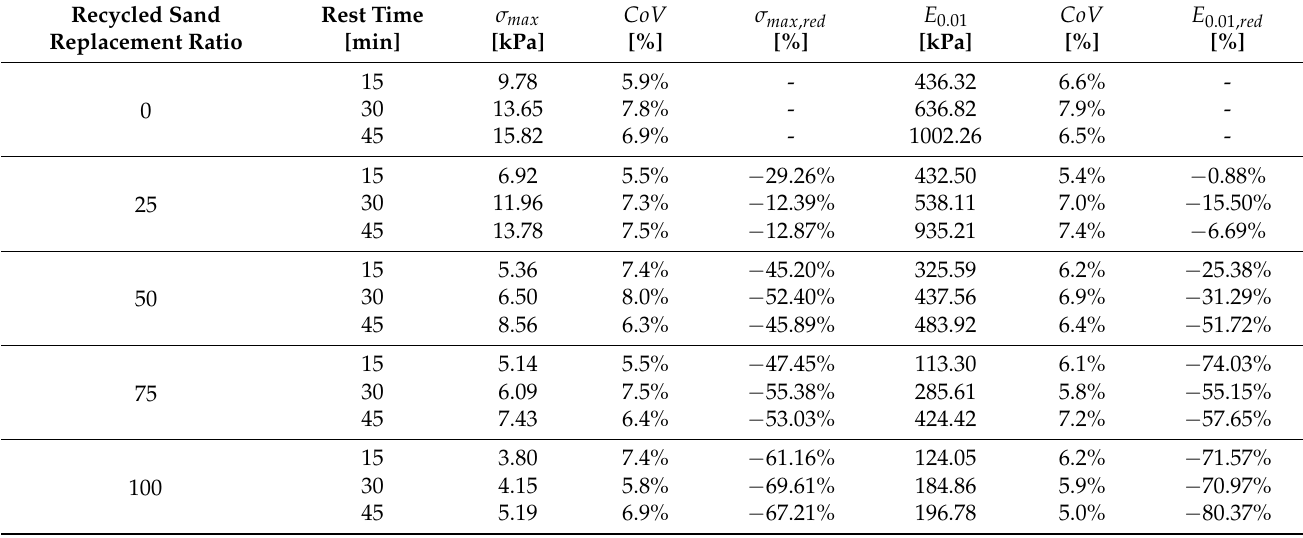
Table 5. Comparison of the maximum compressive stresses (green strength, 𝜎 (cid:3040)(cid:3028)(cid:3051) ) and Young’s